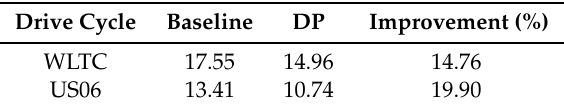
Figure 5. Comparison of the speed trajectories obtained by dynamic programming (DP) and human-driver maneuvers with ( a ) WLTC and ( b ) US06. Table 1. Comparison of the battery state-of-charge (SOC) consumption (%) with the speed profiles obtained by dynamic programming (DP) and nominal